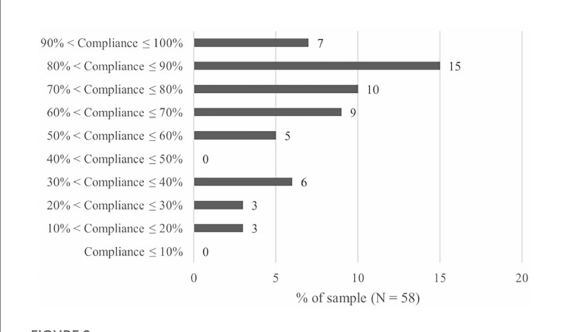
FIGURE2 Distribution of compliance rates for the daily diary